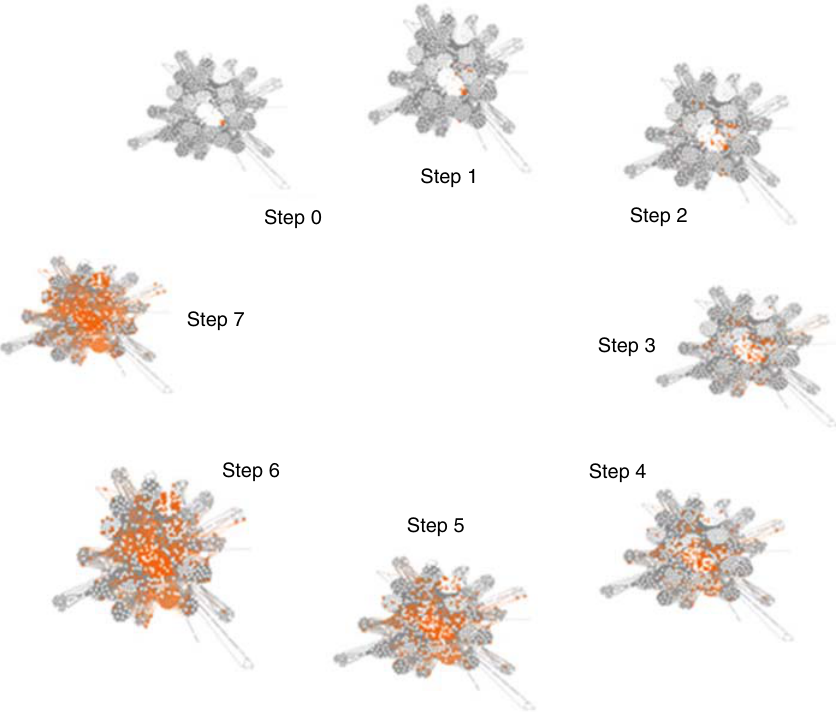
Figure 9. Model of the target network and diffusion simulation